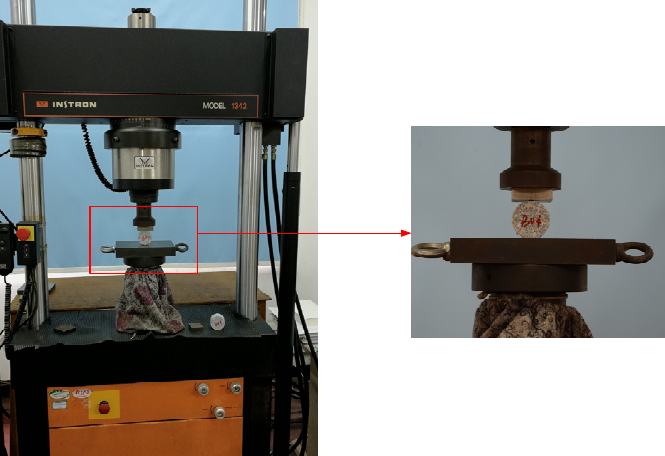
Figure 3. Uniaxial compression experimental device.